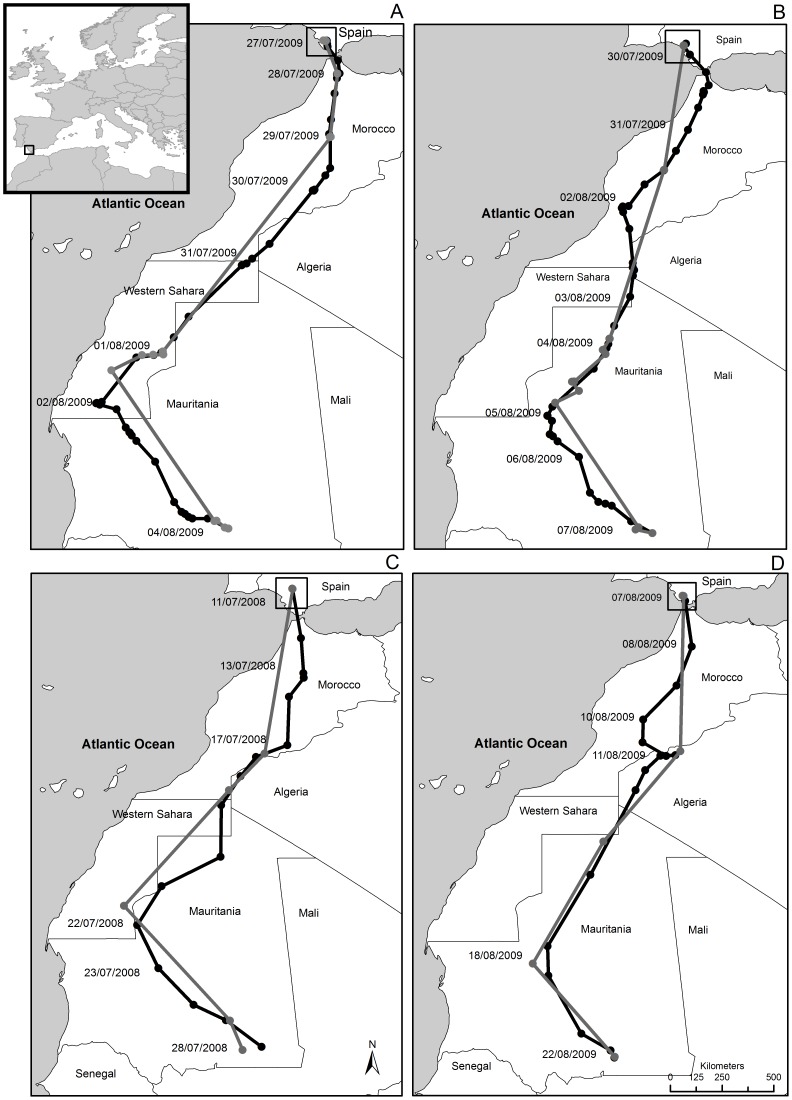
Example of migration paths of four different individual Black Kites as assessed for each one by a GPS tag (black line) and an Argos tag (grey line employing Argos Location Classes 0–3).In panels A and B, locations were subsampled using Approach 1 (all locations used for analysis), while in panels C and D, locations were subsampled using Approach 3 (one location per day), Kites were tagged in Doñana National Park (south-western Spain): its location in Europe is portrayed in the inset. The grey, Argos routes are systematically based on fewer locations and thus composed of fewer straighter segments, resulting in shorter, less tortuous routes and lower migration speeds.